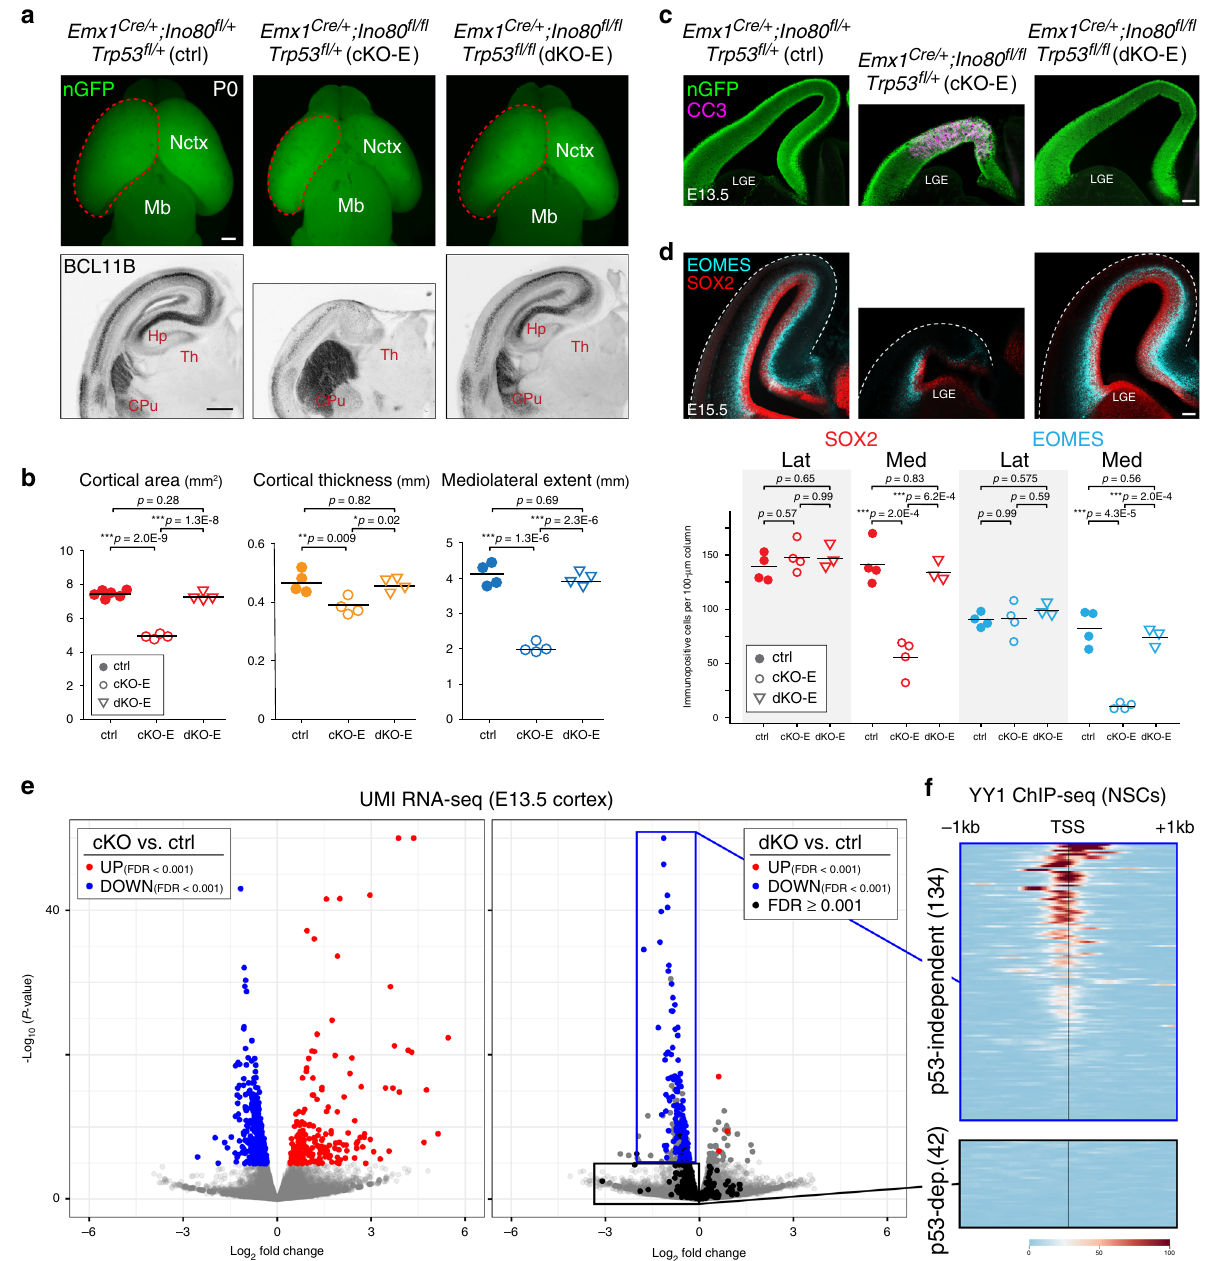
Fig. 5 Trp53 co-deletion rescued Ino80 phenotypes and revealed mechanistically distinct Ino80 roles. a Dorsal view of P0 whole-mount brains and BCL11B immunostaining (black) of P0 coronal sections. Co-deletion of Trp53 with Ino80 (dKO-E) rescued major Ino80 deletion (cKO-E) phenotypes, including microcephaly, severe hippocampal hypoplasia, and disrupted neocortical lamination. Sample measurements quanti fi ed in b are indicated (ctrl cortical area: n = 6, all other measurements: n = 4 animals). b Cortical area (red), thickness (yellow), and mediolateral extent (blue) were restored in dKO- E and not signi fi cantly different compared with ctrl (data are mean, one-way ANOVA with Tukey ’ s post hoc test, ctrl cortical area: n = 6, all other measurements: n = 4 animals). c CC3 immunostaining (magenta) revealed no increase in apoptosis in dKO-E E13.5 neocortex ( n = 3 animals). d The number of SOX2 + (red) and EOMES + (cyan) NPCs in E15.5 dKO-E cortex were restored to levels not signi fi cantly different compared with ctrl (data are mean, one-way ANOVA with Tukey ’ s post hoc test, ctrl: n = 4, cKO-E: n = 4, dKO-E: n = 3 animals). e UMI RNA-seq volcano plots comparing cKO-E with ctrl, and dKO-E ( n = 7 animals) with ctrl E13.5 cortex. In the cKO-E versus ctrl comparison (left panel), differentially regulated genes are